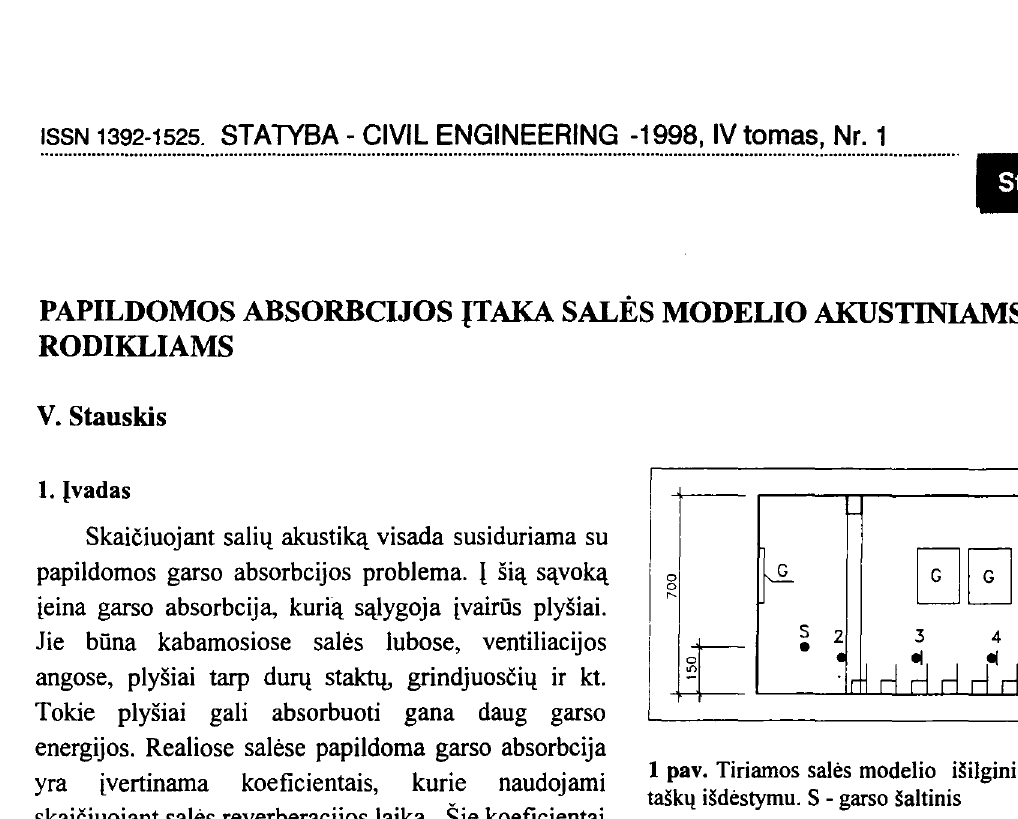
Fig 1. The longitudinal section of the hall under investi gation with the allocation of measurement points. S - sound